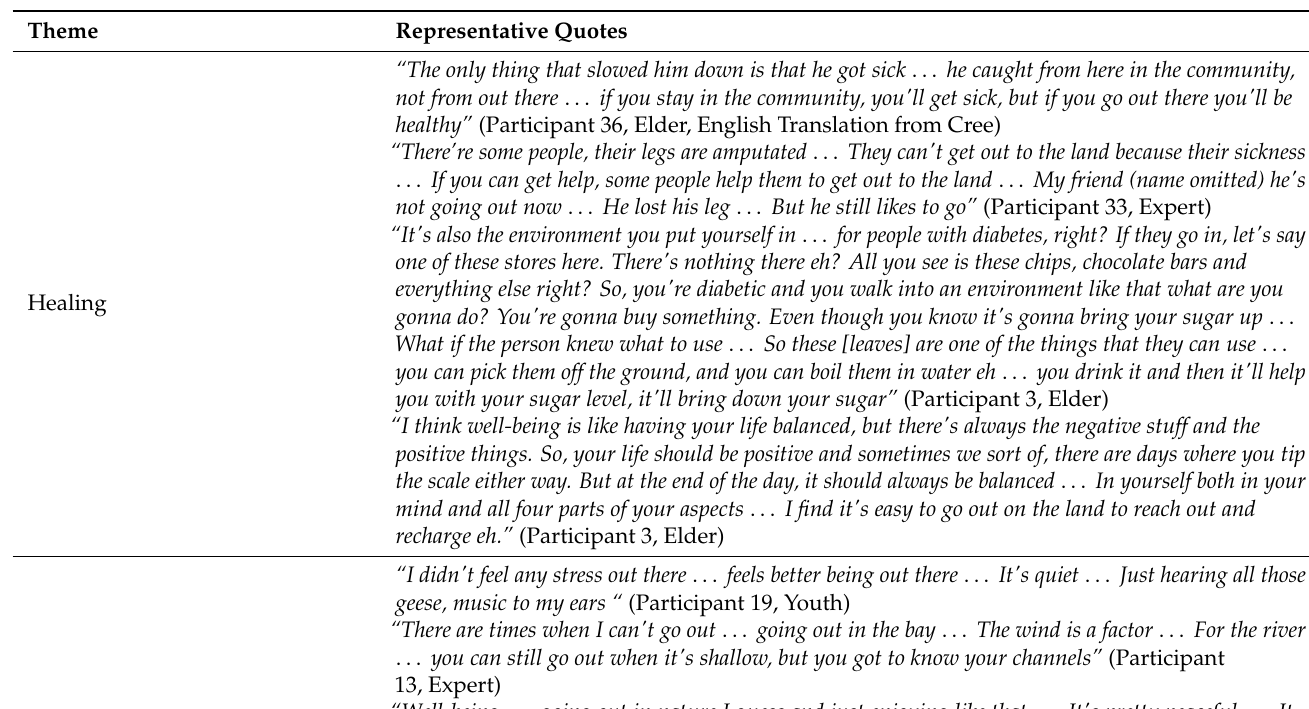
Table A1. Cont. Theme Representative